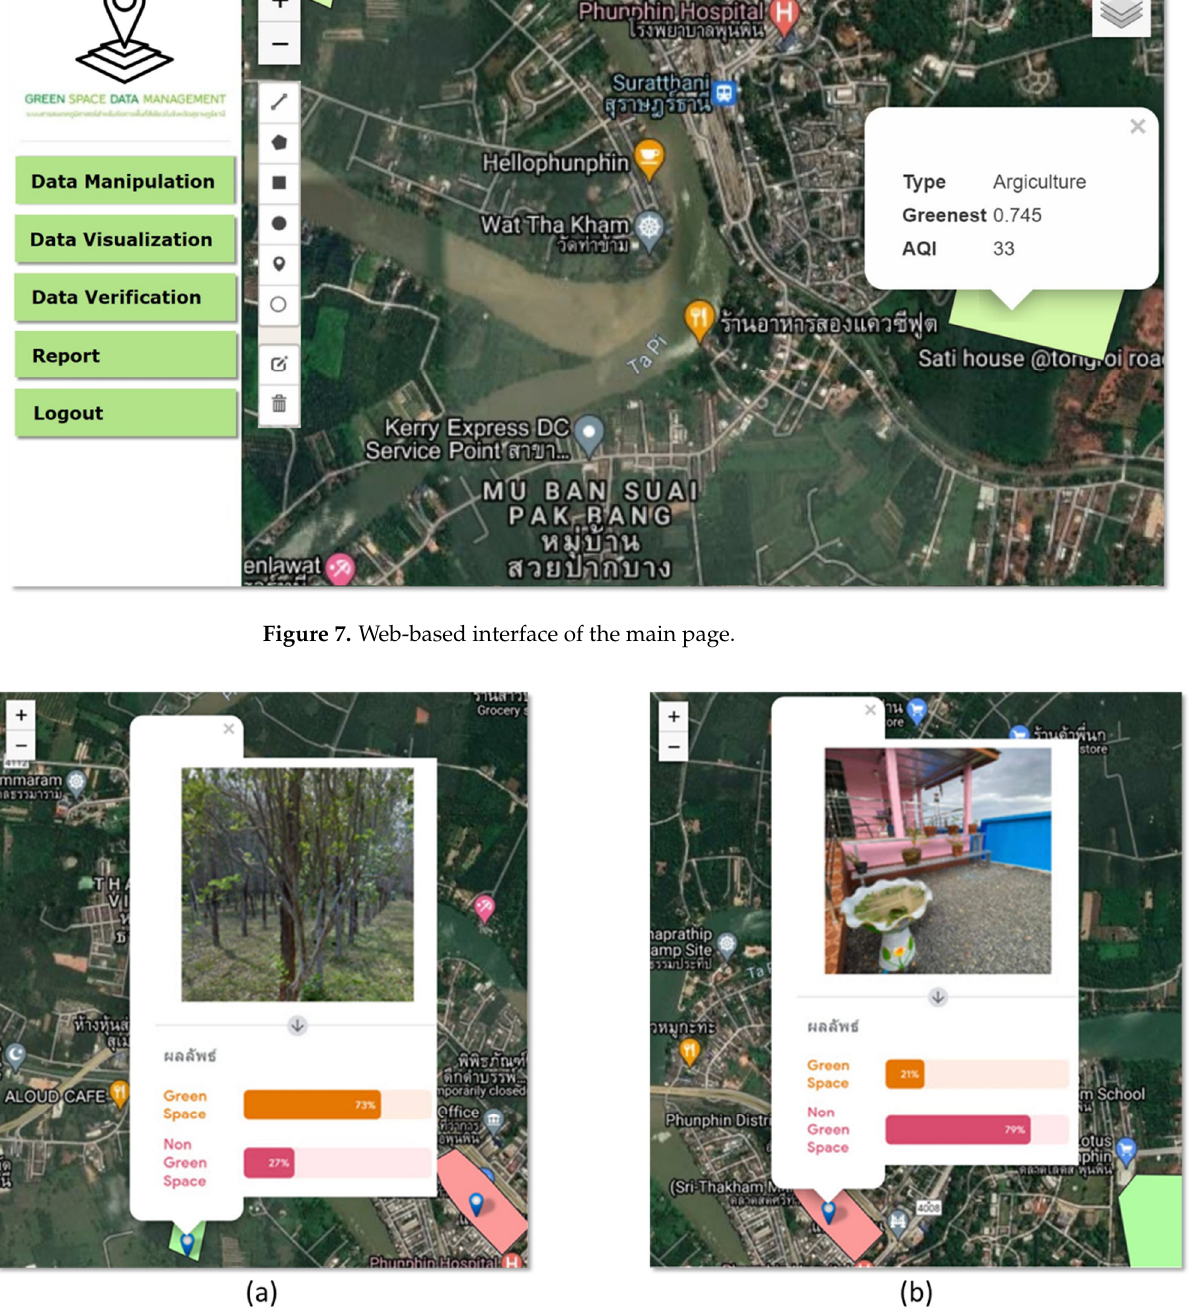
Figure 8. Selected examples of verification by deep learning of submitted green space ( a ) and non-green space ( b ) photographs.